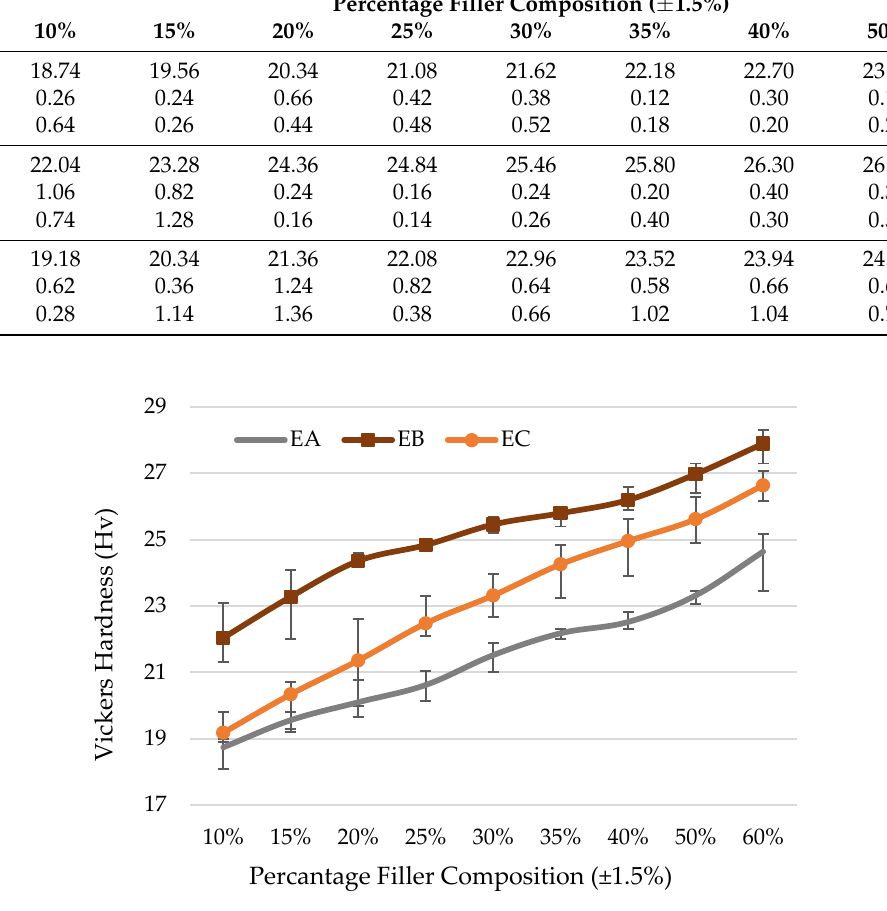
Figure 13. Effects of fillers on the hardness.